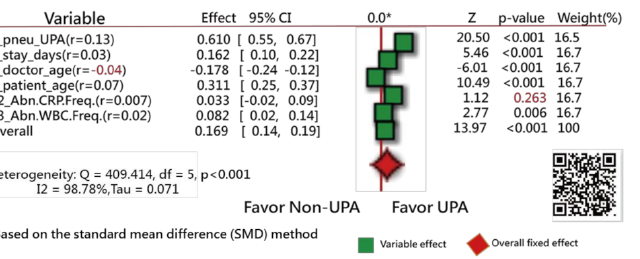
Figure 4. Feature variables using a forest plot to present the interpretation based on the standard mean difference (SMD) method (2).